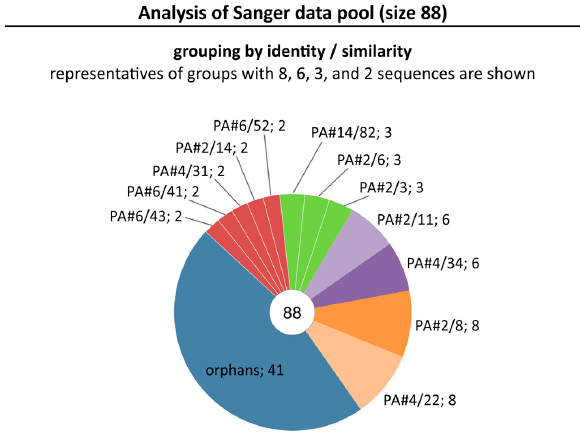
Figure 1. Selected pool of Protein A-binding aptamers after cloning and sequencing. Results of analysis of the Sanger data pool containing 88 sequences are shown. Sequences were grouped with respect to their identity and similarity. The representative of each group and the group size are indicated. Orphans represent sequences with no homology to any other sequence in this pool.